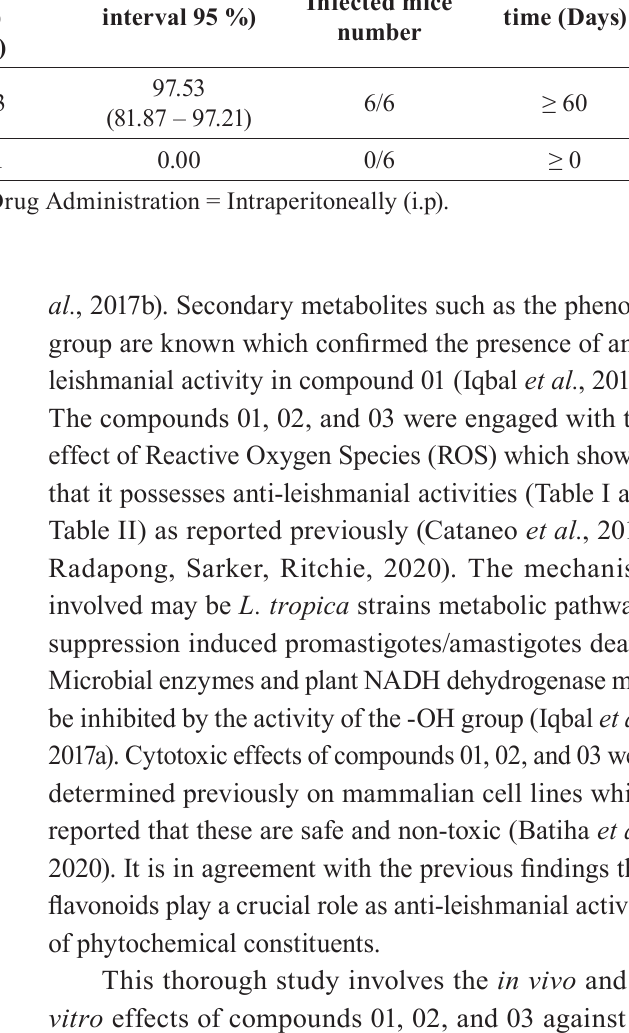
TABLE II - Compounds in vivo anti-leishmanial effect. Table shows the average lesion size in mm ± SD